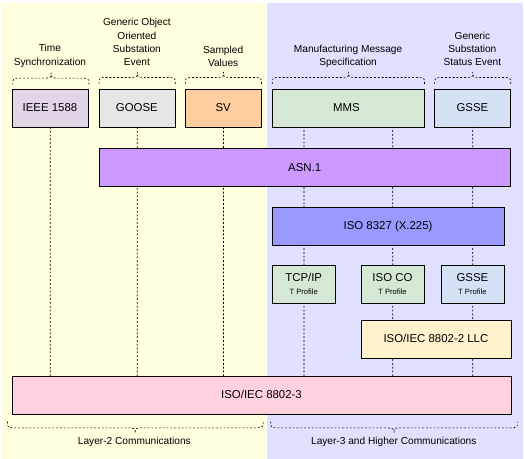
Figure 2. IEC 61850 communication